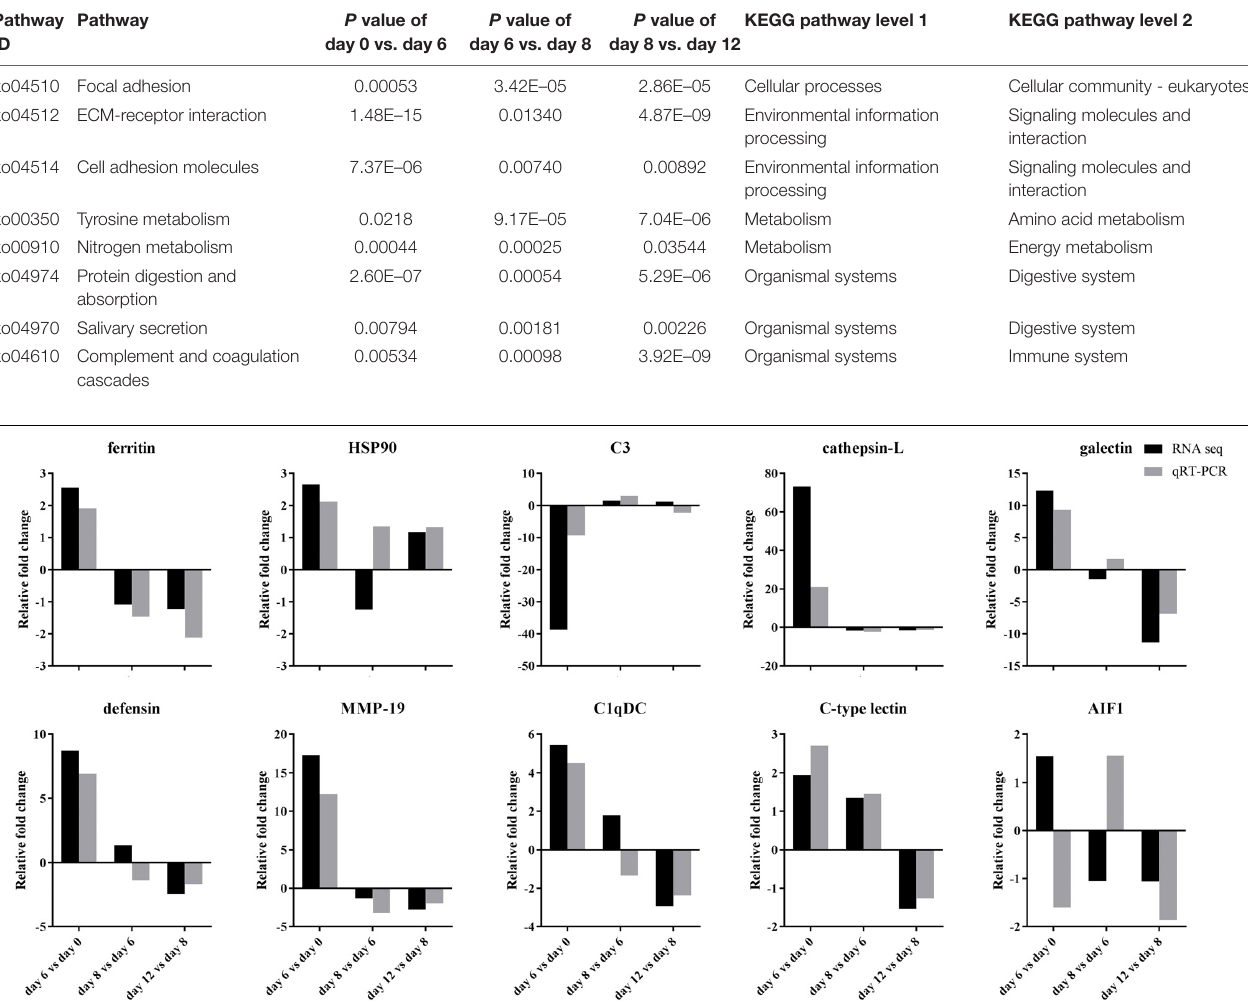
TABLE 3 | Eight highly enriched pathways in all comparing groups ( P < 0.05).